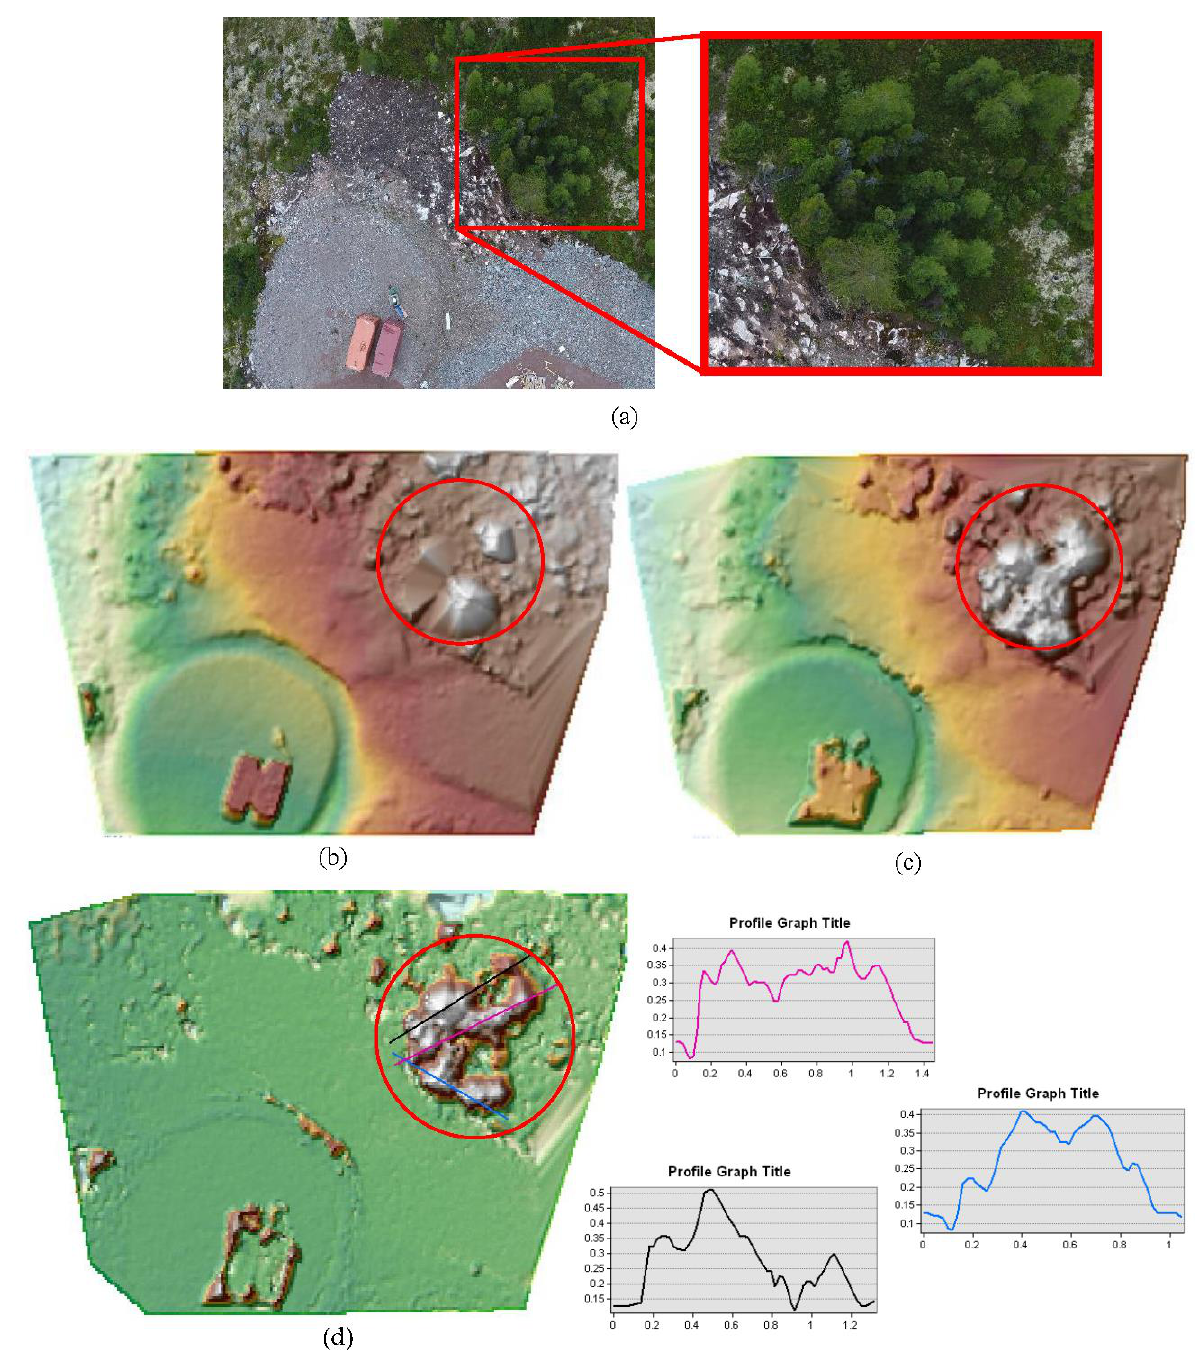
Figure 13. The image captured at the desired area ( a ), the generated DSM by Agisoft ( b ), as well as the proposed method, ( c ) are also shown from the third dataset. The subtraction of two DSMs, in addition to the profile graph, is also demonstrated ( d ).